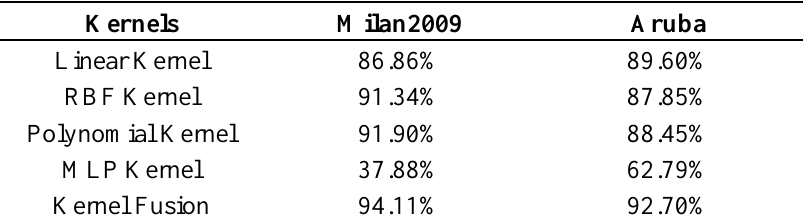
Table 4. Overall kernel functions